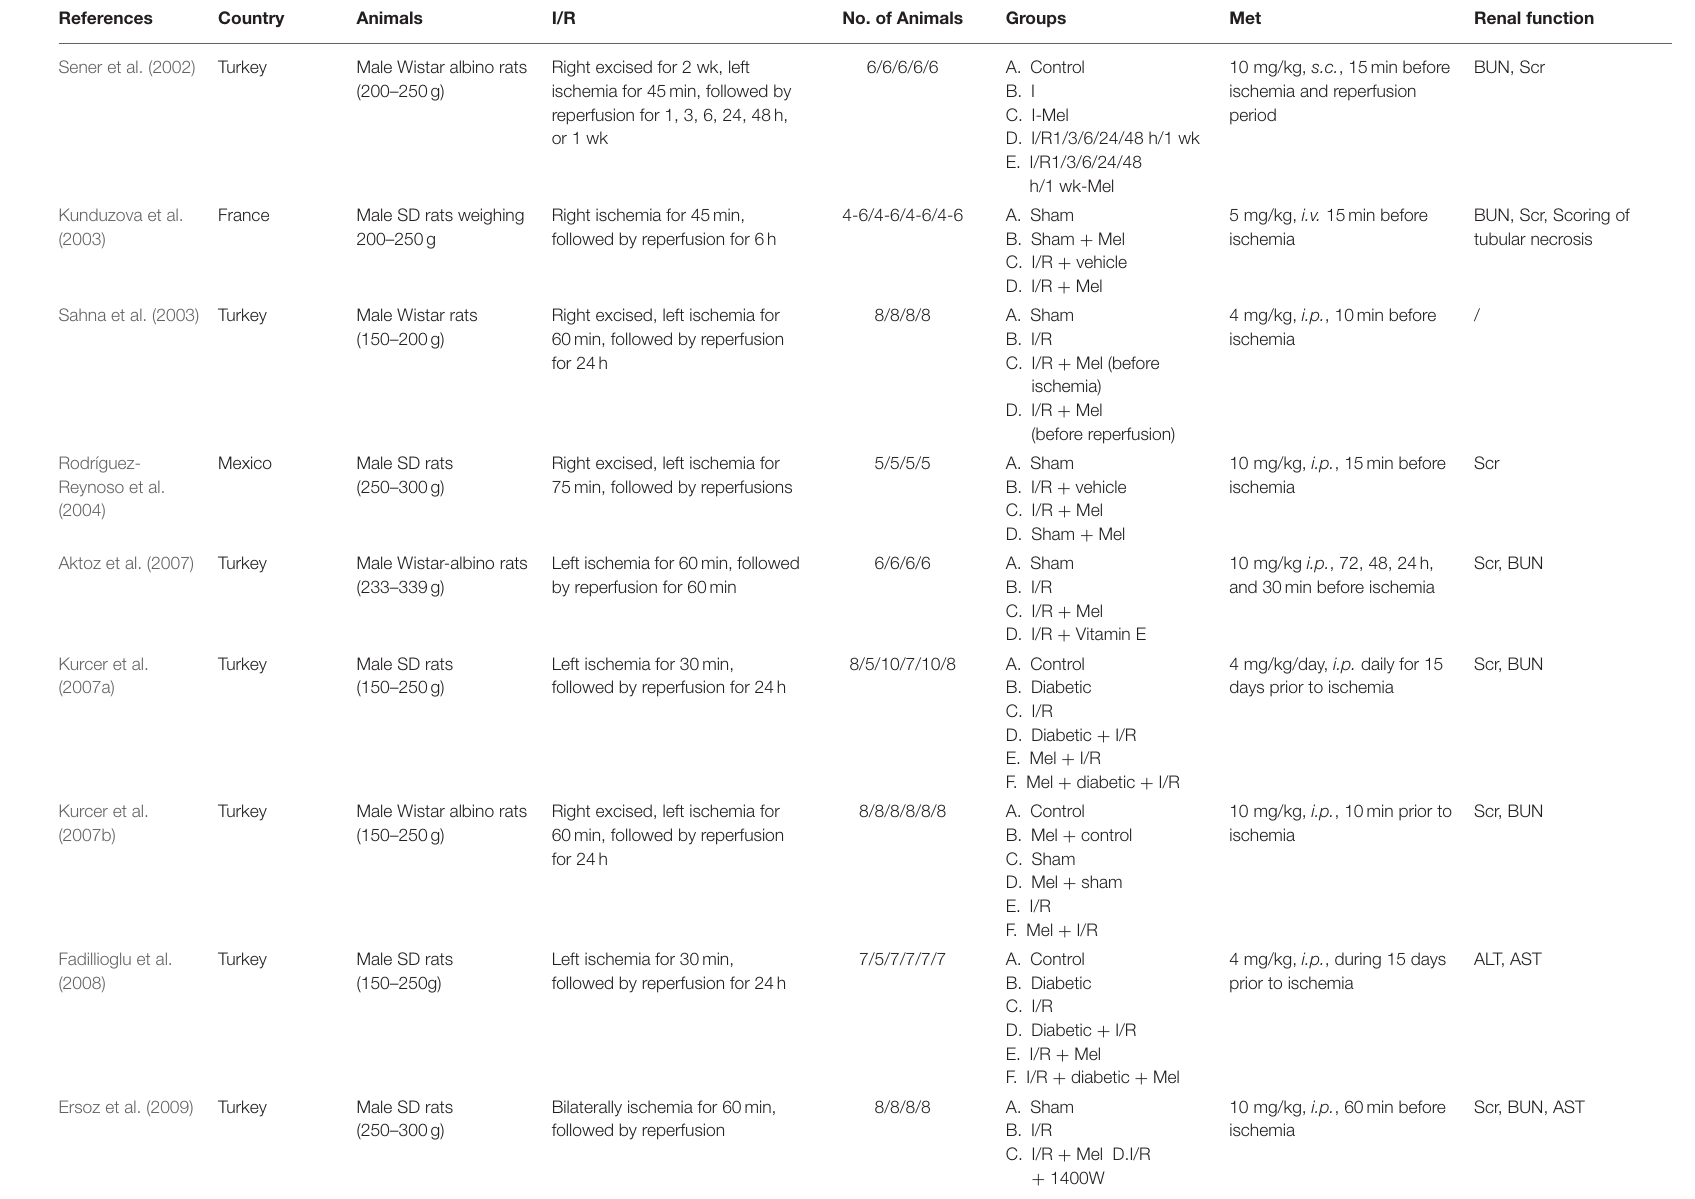
TABLE 1 | Characteristics of the studies included in the